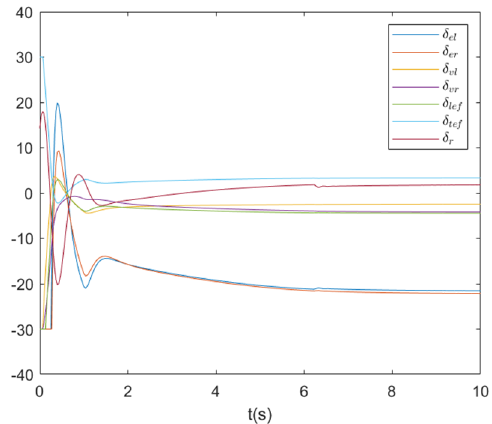
Figure 7. Actuator actions of Fighter 1.